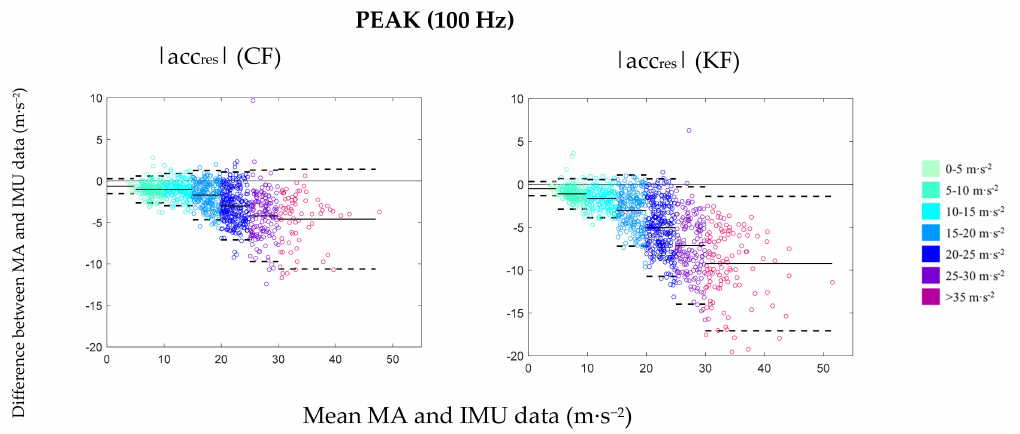
Figure 3. Bland–Altman plots showing the relationship between motion analysis (MA) and IMU data using Complementary Filter (CF) and KF for peak values at the 100 Hz temporal resolution. Mean and peak values for each trial were categorized according to pre-defined bands. For each acceleration band, 95% limits of agreement (LoA) (dashed line) and mean bias (solid line) are displayed with reference to zero (black solid